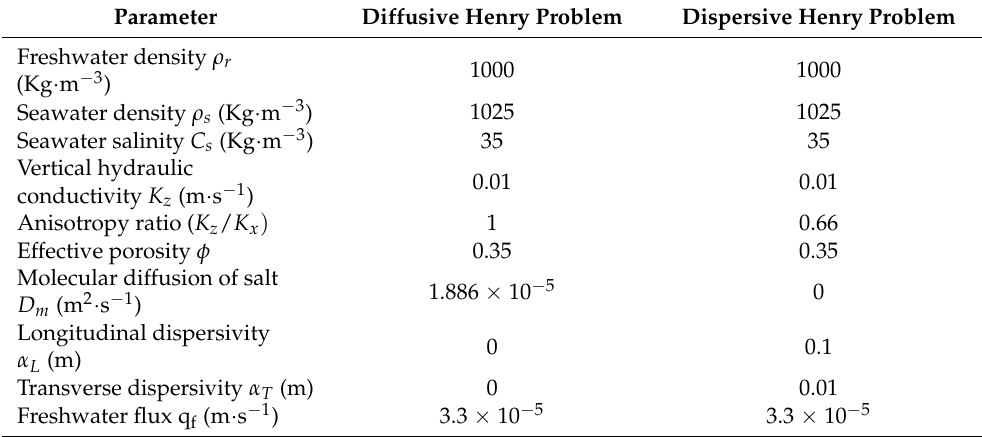
Table 1. Physical parameters used in the diffusive and dispersive variants of the Henry problem. Parameter Diffusive Henry